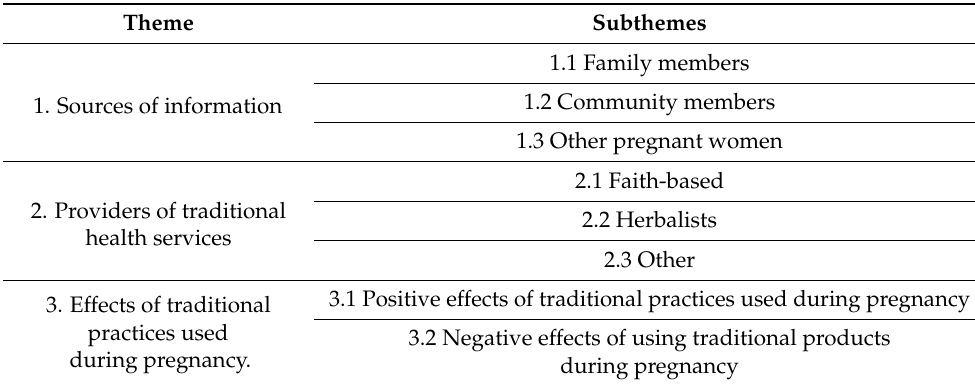
Table 3. Themes and sub-themes emerged for the